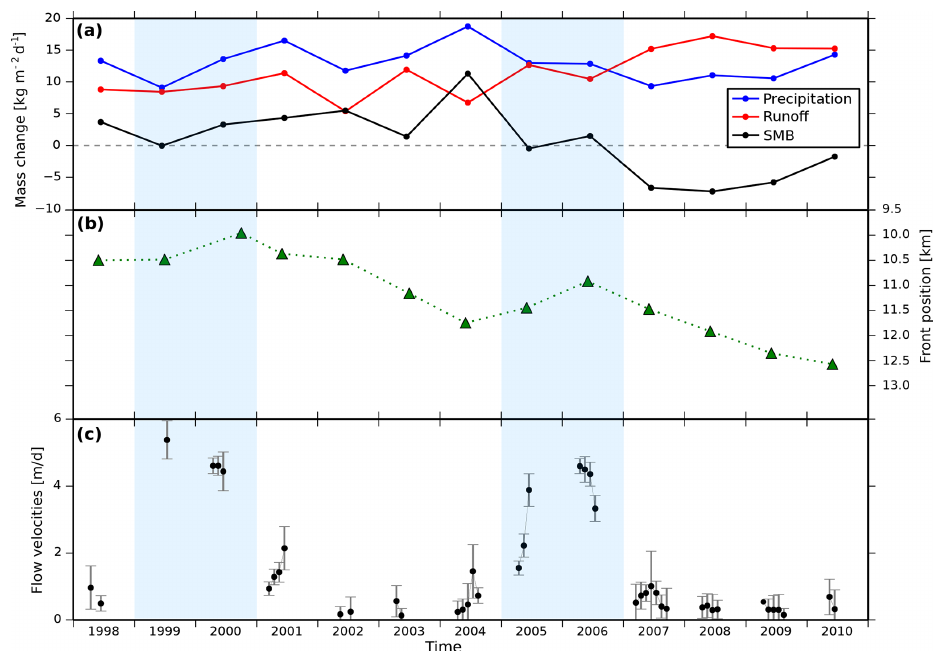
Figure 4. (a) Yearly precipitation, meltwater runoff and SMB averaged over the drainage basin. (b) Monthly front position with respect to the year 1916 digitized in Landsat images where available. (c) Monthly glacier velocity and its uncertainty estimate derived from the Landsat data set at a point close to the terminus of Harald Moltke Bræ (black triangle in Fig. 1). The surges are marked by light blue